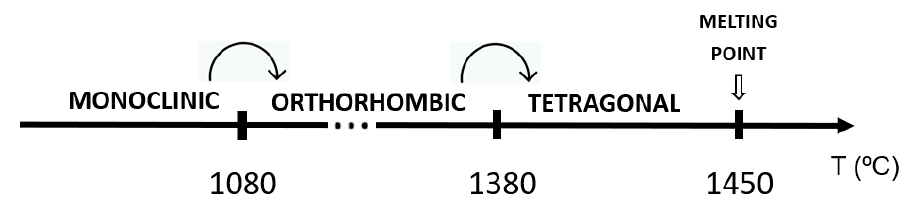
Figure 1. Temperature evolution of the FeNbO 4 polymorphs (adapted from [2]).